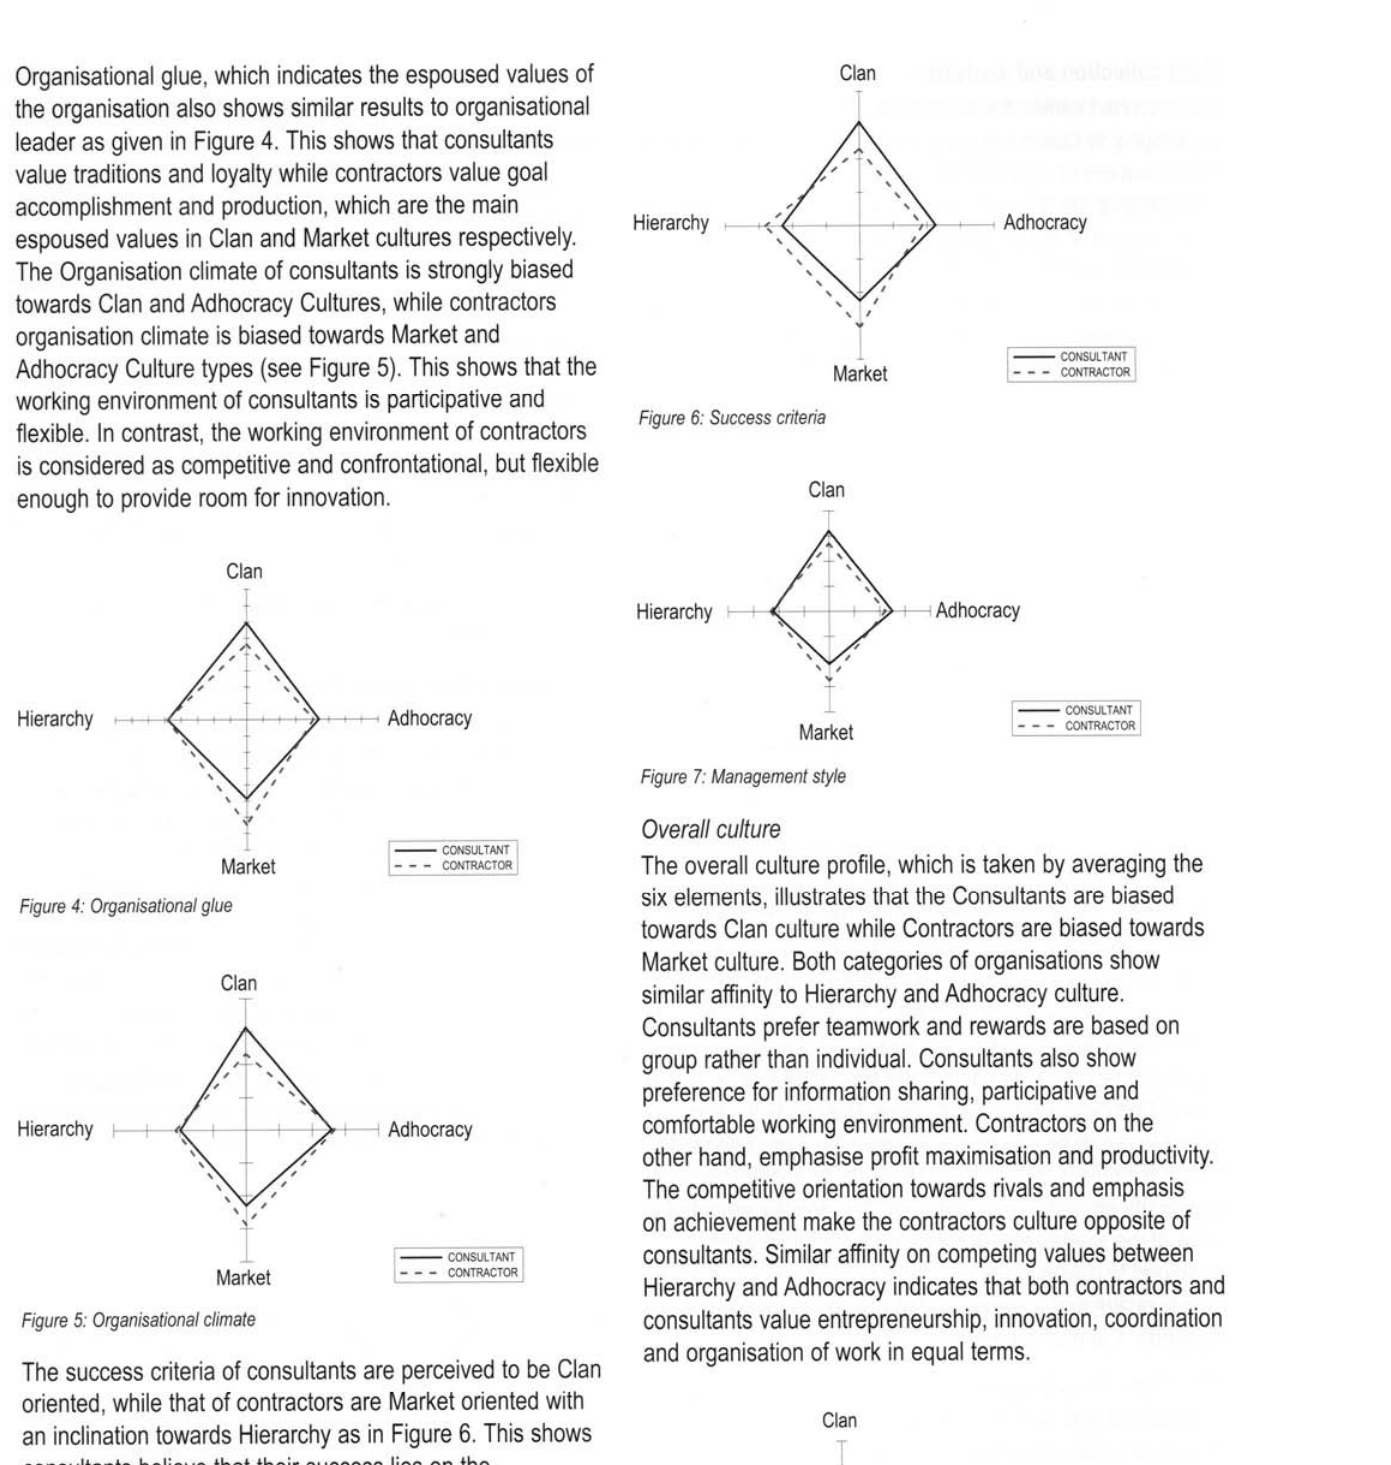
Figure 5: Organisational climate